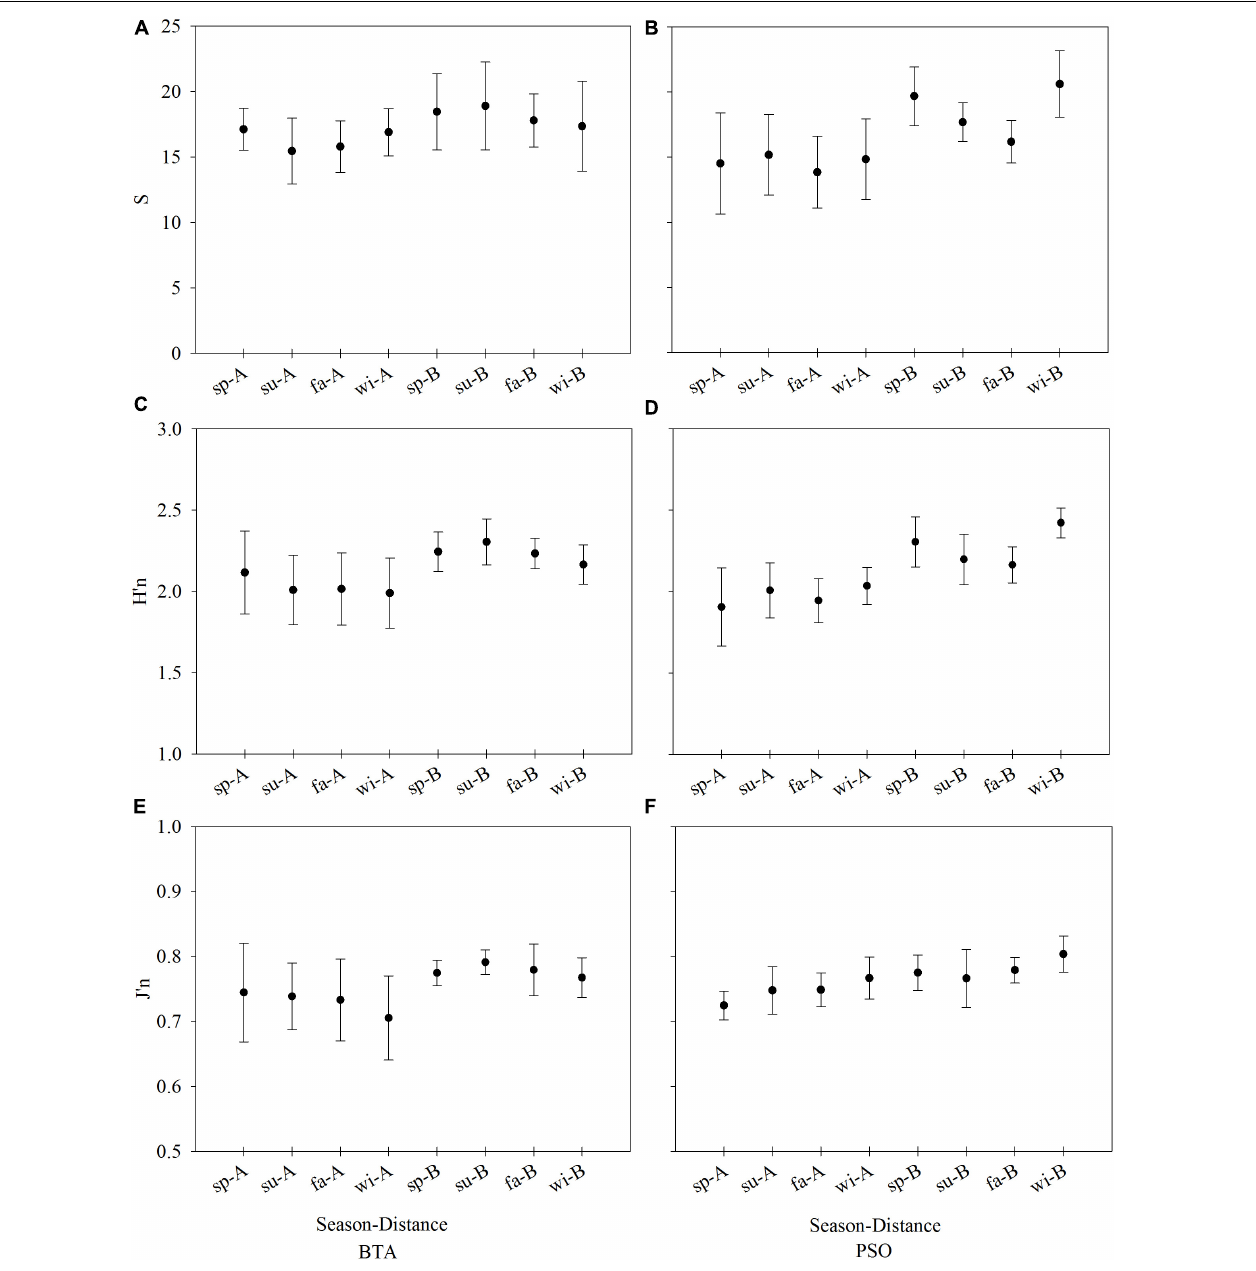
FIGURE 5 | Coral species richness (S, A,B ), diversity index (H’n, C,D ) and evenness (J’n, E,F ) by site, season, and distance zones (mean ± 95% CI). Left column graphs represent Bahía Tamarindo (BTA) and right column Punta Soldado (PSO). Seasons are defined as: sp, spring; su, summer; fa, fall; wi,